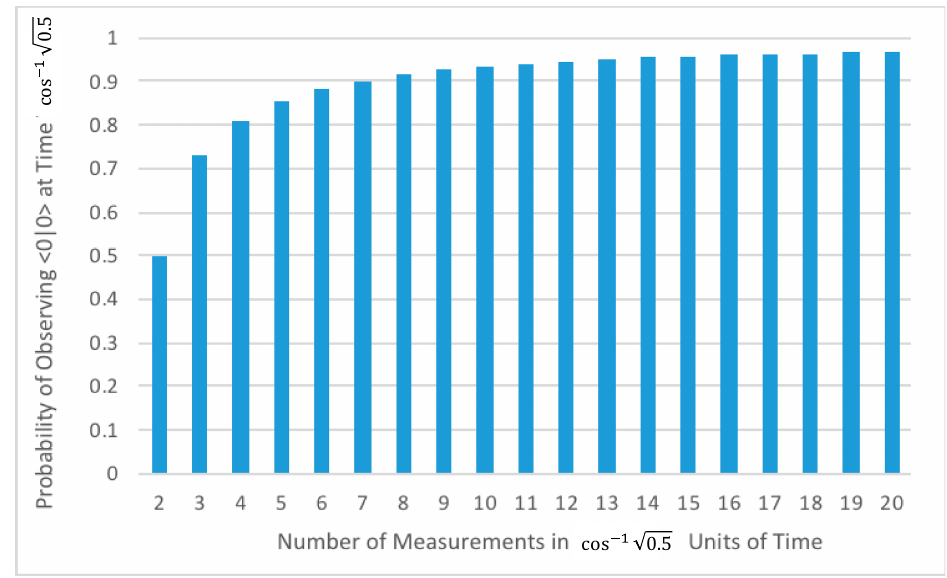
Figure 3. Rapid measurement holds quantum system at same state.